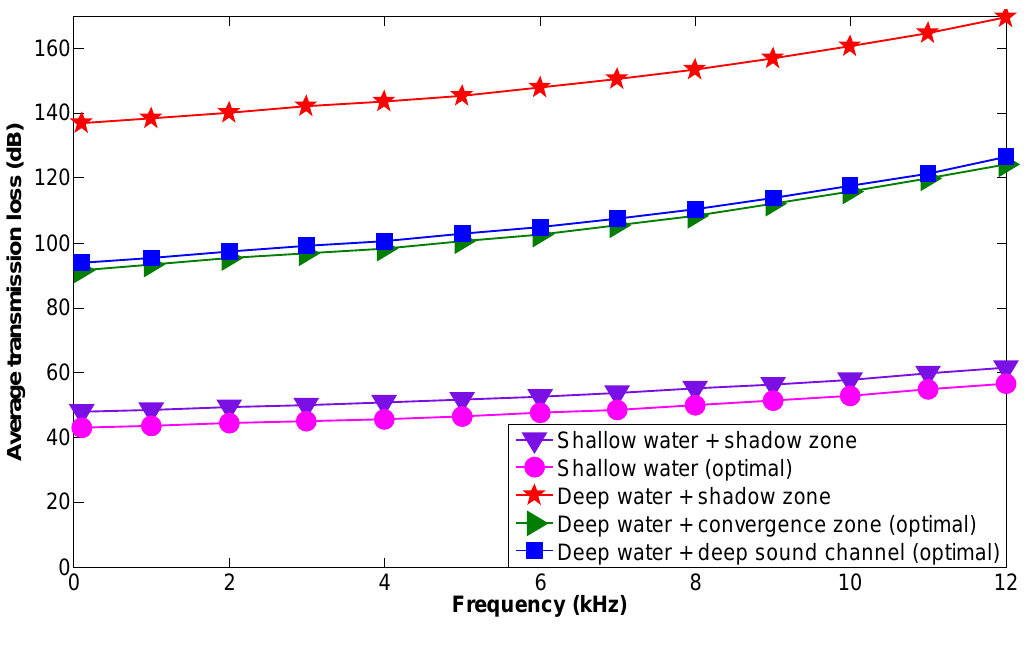
Figure 16. Average transmission loss of a link as a function of frequency in shallow and deep